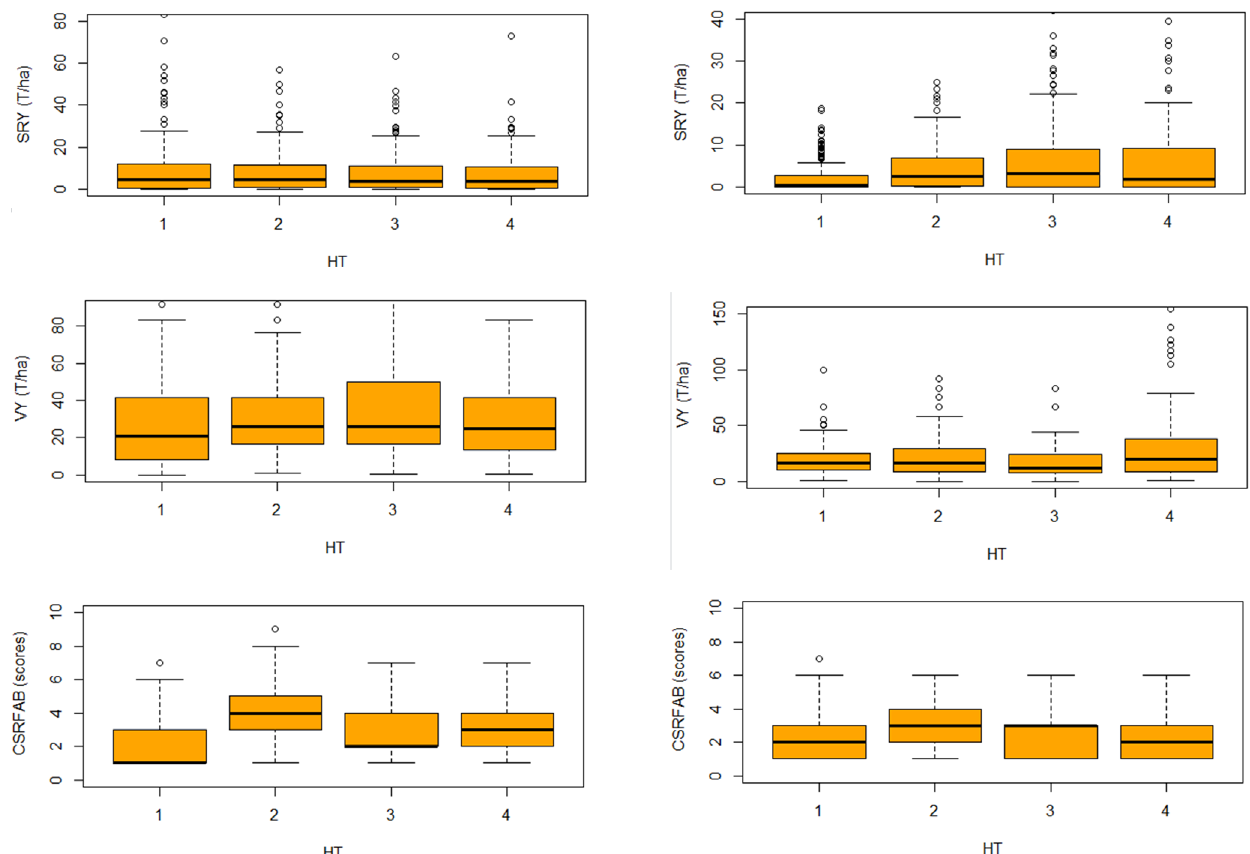
Figure 7. Two seasons (2016B & 2017A) boxplot comparison showing overall variability and dispersion of storage root yield (SRY), vine yield (VY) and continuous storage root formation and bulking (CSRFAB) over 4 harvest times (HT) among 130 sweetpotato genotypes at the National Semi-Arid Resources Research Institute (NaSARRI), Serere. Note: SRY = storage root yield; VY = vine yield; HT = harvesting time; 1 = 90DAP; 2 = 120 DAP; 3 = 150 DAP; 4 = 180